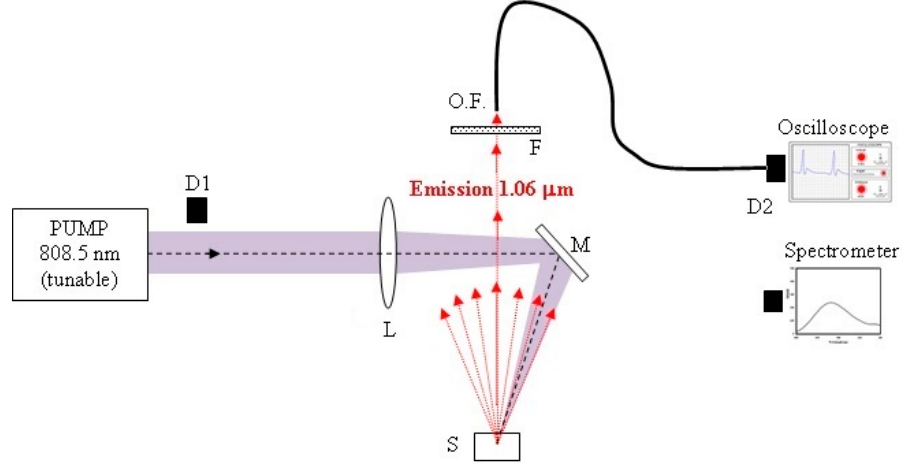
Figure 2. Experimental setup of RL experiments. Pump: tunable Ti:sapphire laser; D1: pump pulse measuring detector; L: movable focusing lens; M: plane mirror; S: sample; F: pump removing filter; O.F.: optical fiber; D2: emission pulse measuring detector, coupled to digital oscilloscope. The fiber end is carried to the spectrometer for spectral measurements.